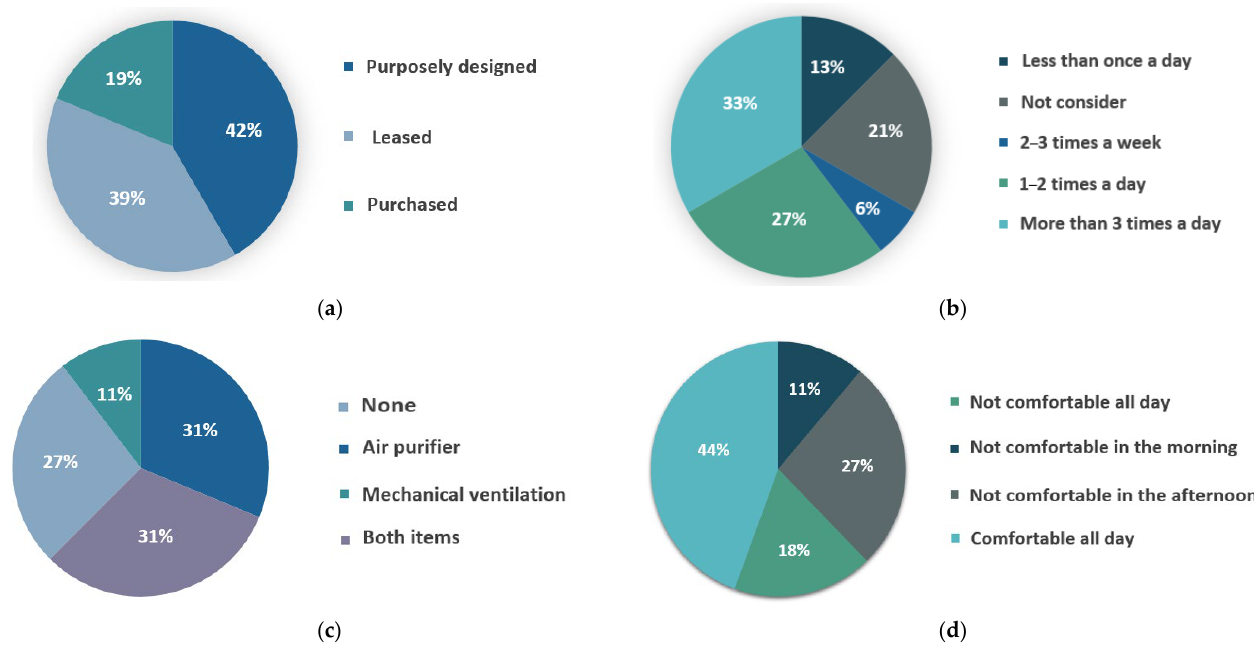
Figure 4. Representative results of the office space survey of 45 office workers: ( a ) questionnaire Table 1 a-4 and ( b ) questionnaire Table 1 c-1, ( c ) questionnaire Table 1 d-1 and ( d ) questionnaire Table 1 f-1. Table 1. Questionnaire